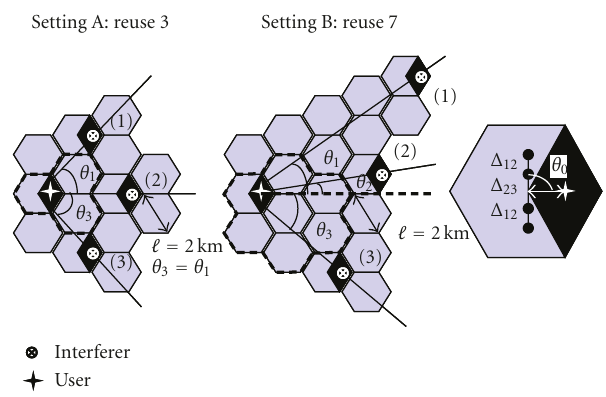
Figure 1: Two cellular systems with hexagonal cells and trisectorial antennas at the base stations (reuse factor F = 3, setting A, on the right and F = 7, setting B, on the left). The array is equipped with N = 4 antennas. Shaded sectors denote the allowed areas for user and the three interferers belonging to the first ring of interference (dashed lines identify the cell clusters of frequency reuse).